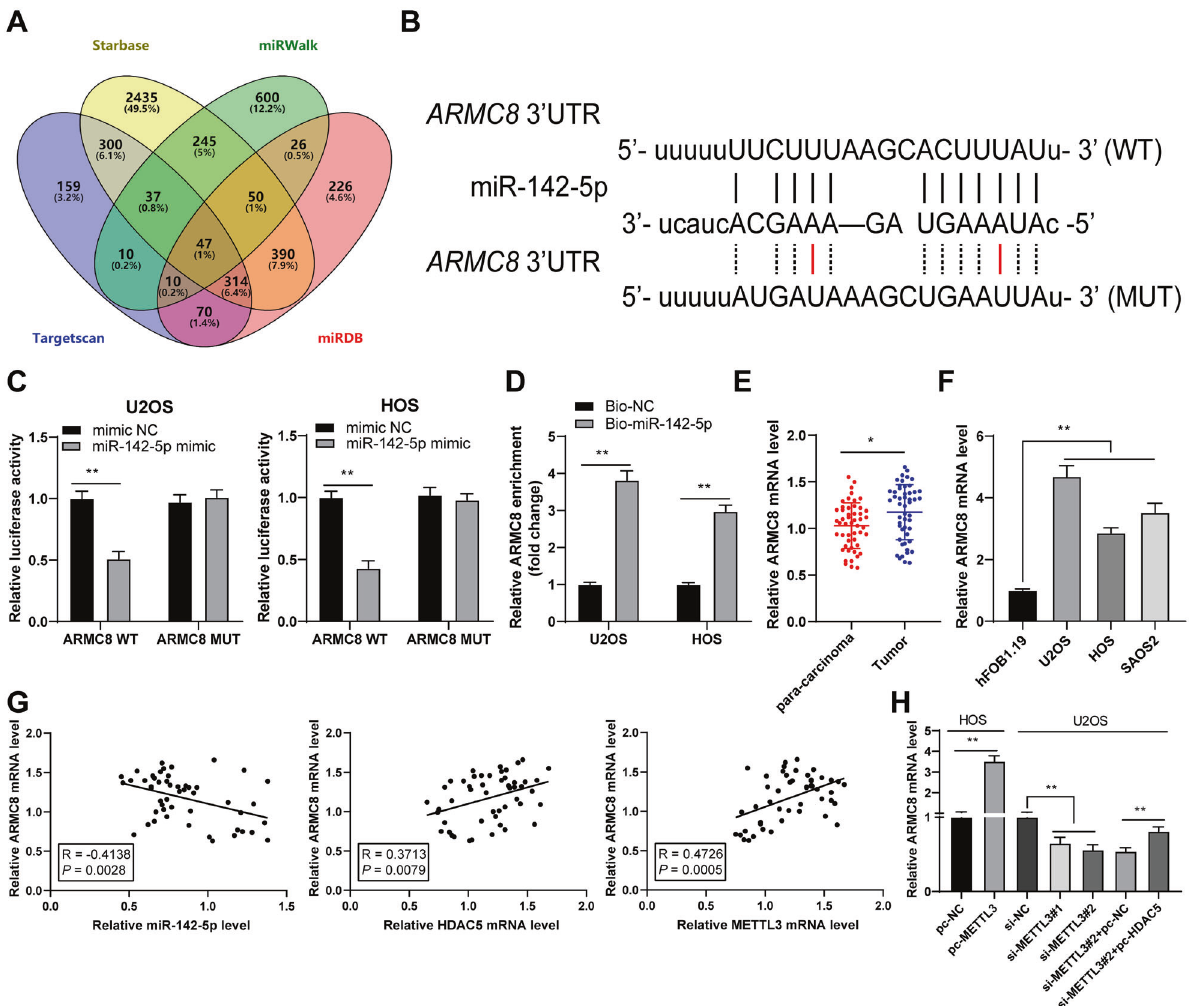
Fig. 6 miR-142-5p targeted ARMC8. A The target genes of miR-142-5p were predicted through Starbase, miRWalk, Targetscan, and miRDB databases. B The binding site of miR-142-5p and ARMC8 in the Starbase database. C , D The binding of miR-142-5p and ARMC8 in OS cells was veri fi ed using dual-luciferase assay and RNA pull-down. E ARMC8 mRNA level in 50 pairs of OS tissues and adjacent tissues was determined using RT-qPCR. F ARMC8 mRNA level in human OS cell lines (U2OS, HOS, SAOS2) and normal osteoblasts (hFOB1.1) was determined using RT- qPCR. G The correlation between ARMC8, miR-142-5p, HDAC5, and METTL3 in OS tissues was analyzed using Pearson correlation analysis. H ARMC8 mRNA level in OS cells after intervention with METTL3 and HDAC5 expression was measured using RT-qPCR. N = 50. The cell experiment was repeated three times independently. Data in panels C-D/F-H are presented as mean ± standard deviation. Data in panel E were analyzed using paired t -test. Data in panels F / H were analyzed using one-way ANOVA, and data in panels C , D were analyzed using two-way ANOVA, followed by Tukey ’ s multiple comparisons test, * p < 0.05, ** p <